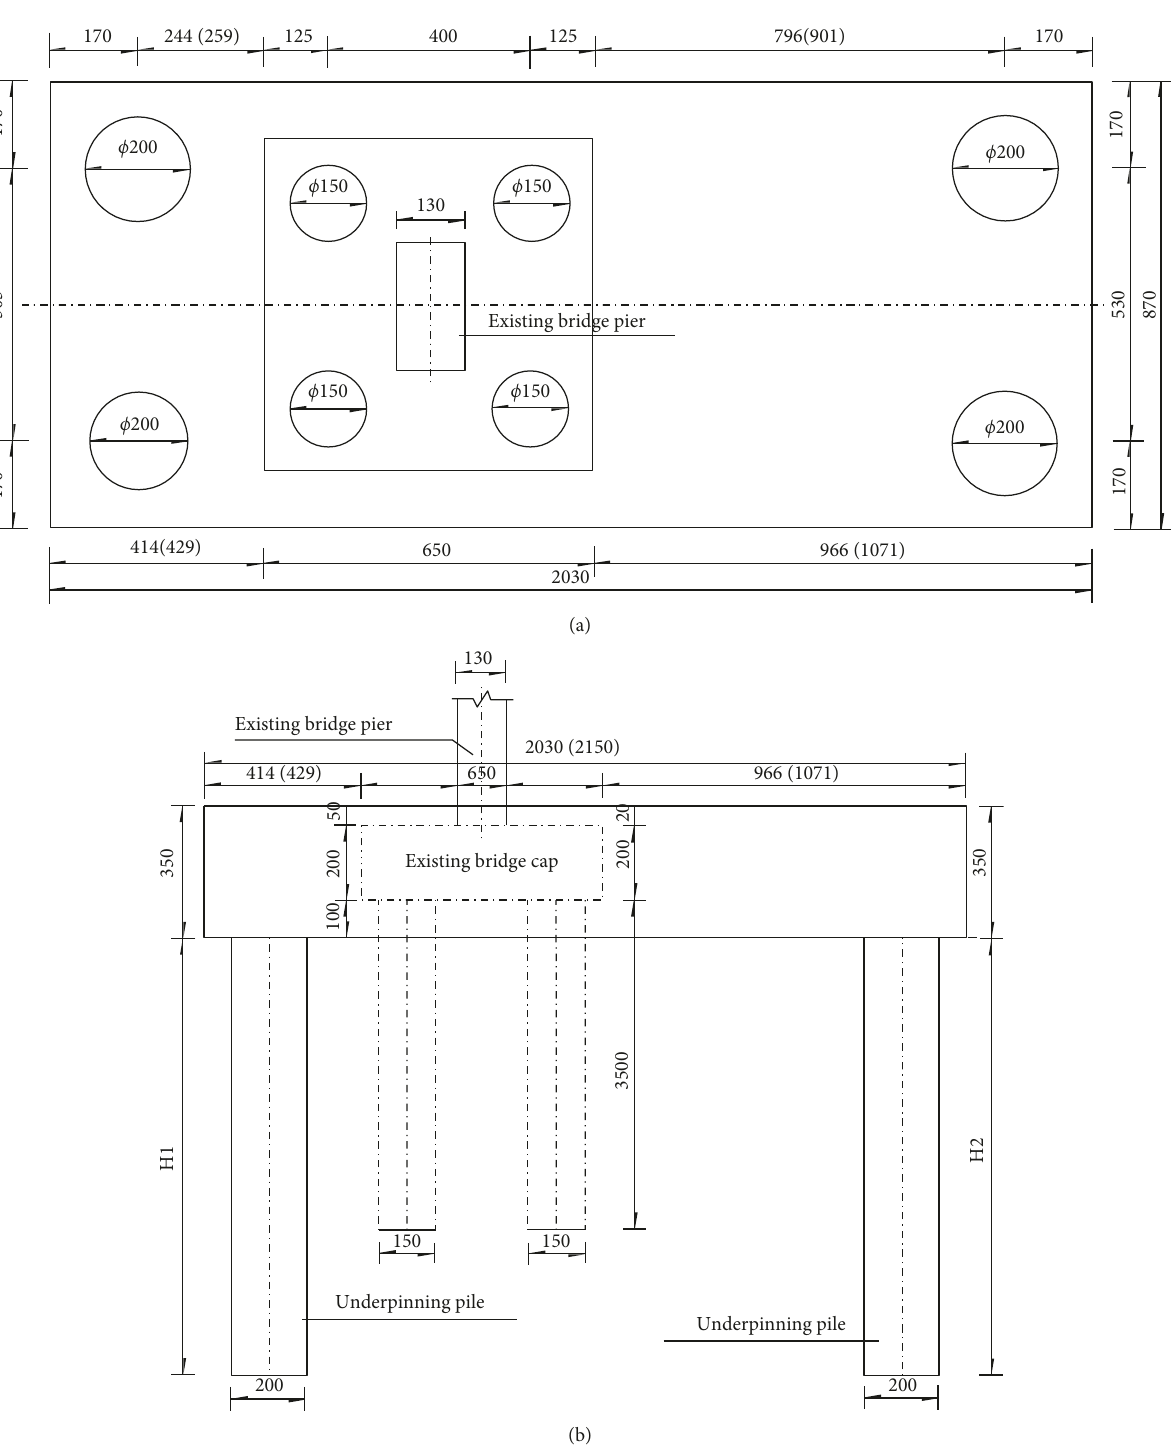
Figure 2: Underpinning structure. (a) The plane diagram and (b) longitudinal section diagram of the underpinning beam (unit: